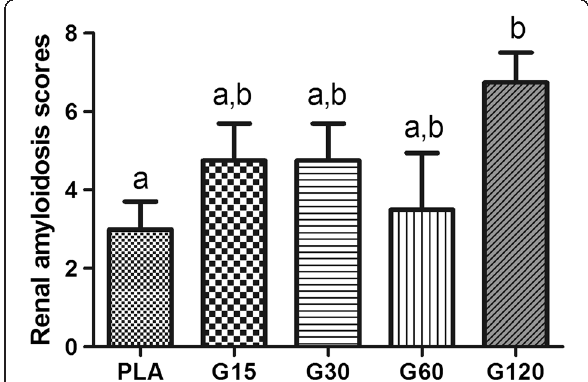
Figure 5 Median scores for renal amyloidosis in rats submitted to spinal cord injury. Controls were injected with sterile water (PLA) and other groups received different doses of MVIIC (15, 30, 60 and 120 pmol). Lowercase letters express statistically differences among groups, after eight days of spinal cord injury (Kruskal-Wallis test and Dunn ’ s post hoc test; p <